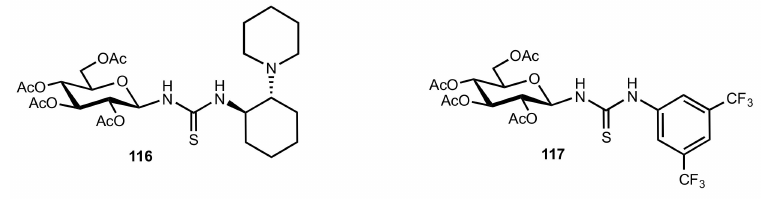
Figure 13. The structure of organocatalysts 116 and 117 .